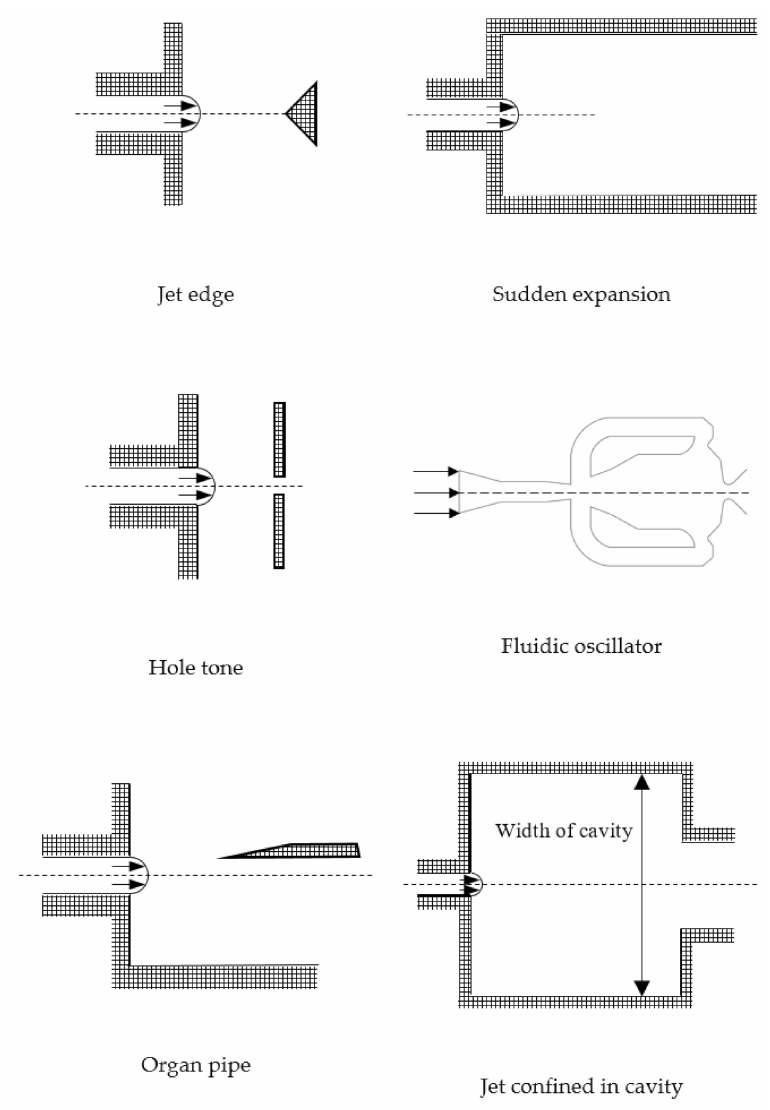
Figure 1. Classification of self-sustained